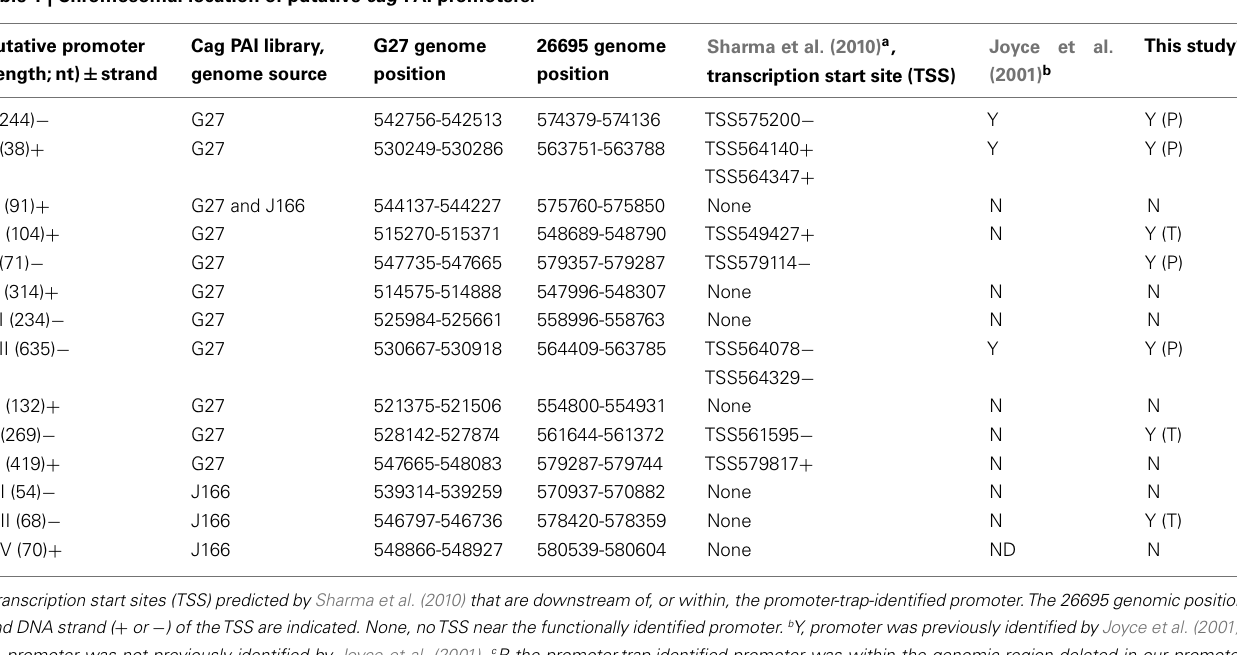
FIGURE 4 | Promoter-trap-identified promoters and proposed transcript map on the H. pylori cag PAI. Each gene on the cag PAI is represented by a thick black arrow, oriented in the direction of transcription, whose length and spacing are approximately proportional to the annotated gene length and intergenic spacing. DNA segments represented in the promoter library that contained functional promoters (numbered I–XIV) to correspond with Table 1 and sequences in TableA5 in Appendix) are shown as small gray flags